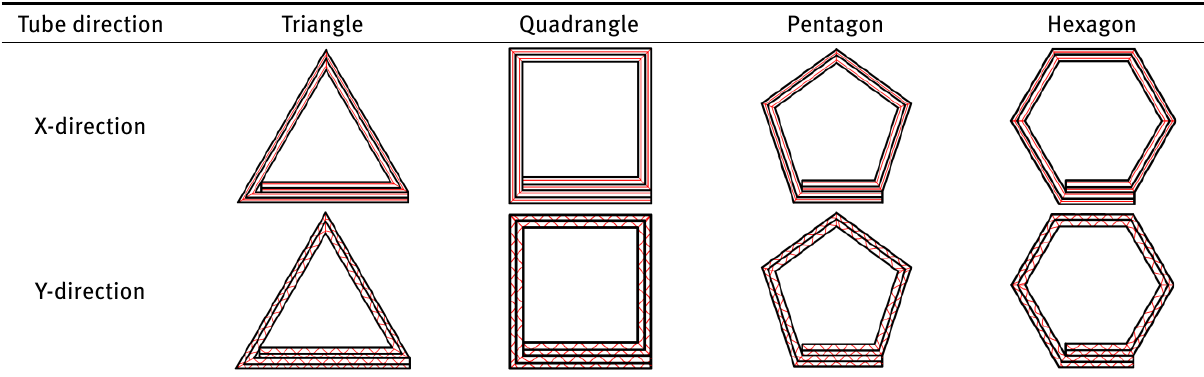
Table 1: Geometry of paper corrugation tubes of regular polygon cross-section shape